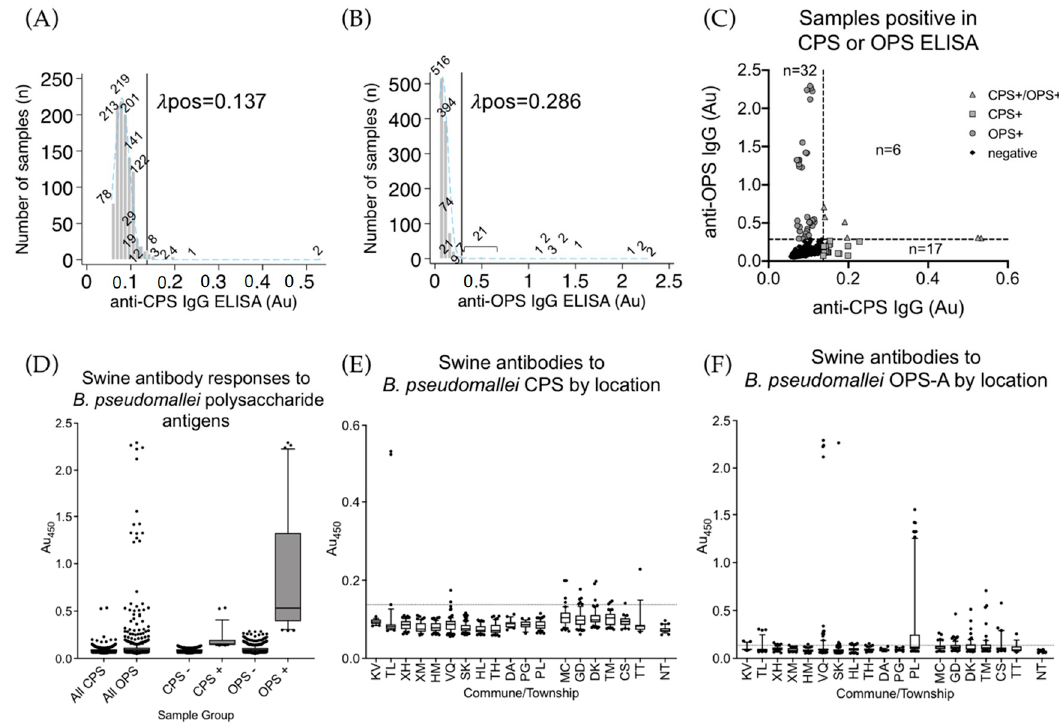
Figure 1. Anti-CPS and OPS IgG ELISAs. ( A ) A histogram of 1056 swine serum samples from Vietnam tested for anti-CPS IgG antibodies. The cutoff threshold for the CPS ELISA assay is indicated by the vertical black line at 0.137 Au. The light blue dashed line indicates the normal distribution of the CPS seronegative population. The numbers above each bar indicate the total number of samples in each of 53 bins. ( B ) A histogram of 1056 swine serum samples tested for anti-OPS IgG antibodies. The cutoff threshold for the OPS ELISA assay is indicated by the vertical black line at 0.286 Au. The light blue dashed line indicates the normal distribution of the CPS seronegative population. The numbers above each bar indicate the total number of samples in each of 53 bins. ( C ) A comparison of anti-CPS IgG and anti-OPS IgG for the 1056 serum samples. Grey triangles are samples that were positive for CPS and OPS assays. Grey squares are samples positive in only the CPS assay, grey circles are only positive in OPS assay, and the black dots are the seronegative population. ( D ) The absorbance values obtained in the CPS and OPS-A ELISAs of all samples (all), samples not passing cutoff (CPS- and OPS-), and those passing cutoff (CPS+ and OPS+). ( E ) Swine antibody responses by commune/township as detected in the CPS ELISA. The dotted line indicates calculated cutoff value of 0.137 Au. ( F ) Swine antibody responses by commune/township as detected in the OPS-A ELISA. The dotted line indicates the calculated cutoff value of 0.286 Au. Boxes are the interquartile range. Whiskers indicate the 10th and 90th percentiles. Black dots indicate individual samples outside of these ranges. Location codes can be found in Table 1.